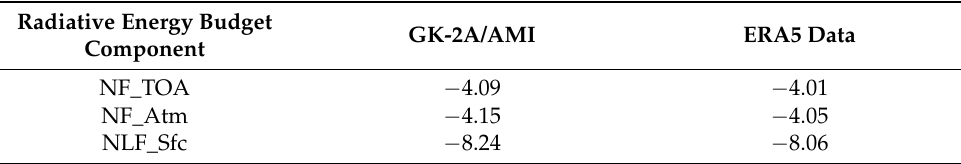
Figure 3. Monthly means for sensible and latent heat flux (SHF, LHF) during January and July 2021, from ERA5. Table 4. Comparisons of radiative energy budgets calculated by GK-2A/AMI and ERA5. Units for Radiative Energy Budget Components: W · m − 2 .